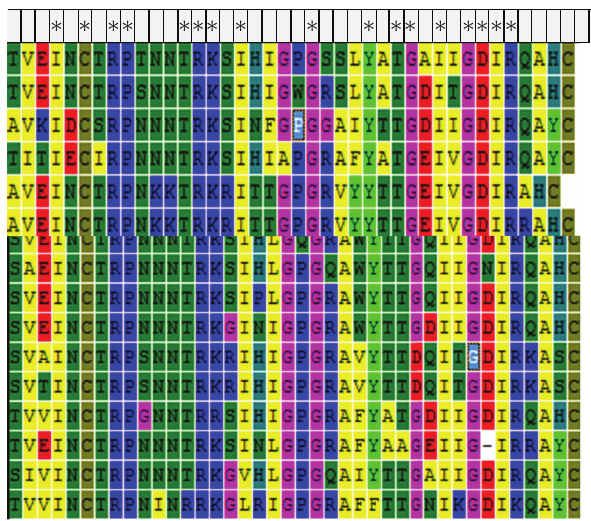
Figure 4: Aligned sequences exhibiting the consensus region of V3 loop (indicated by ∗